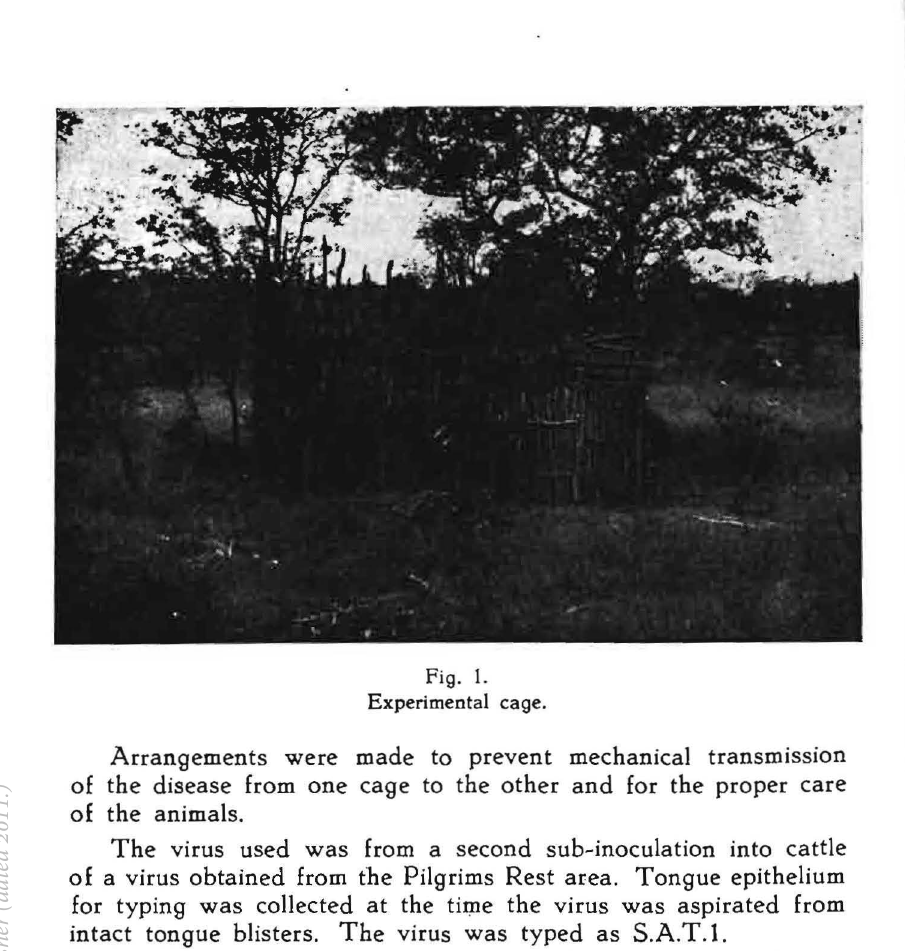
Fig. 1. Experimental